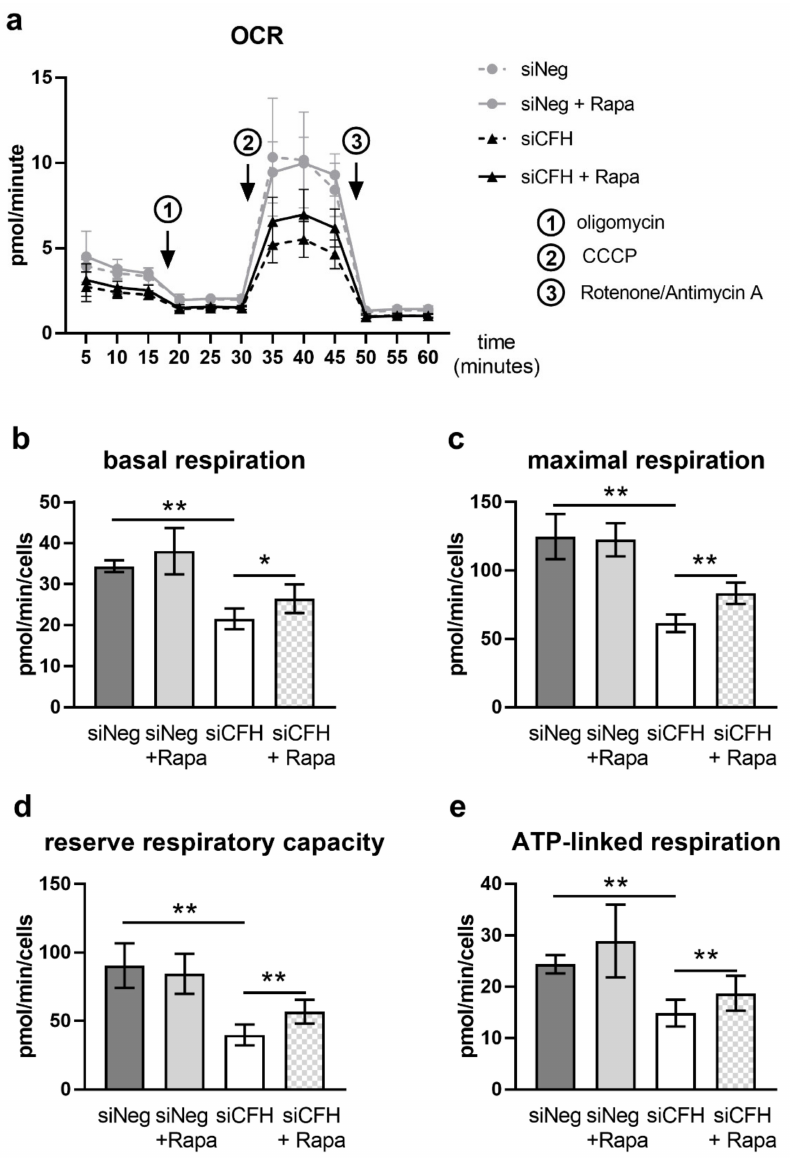
Figure 2. Rapamycin partially rescues FH knockdown-mediated mitochondrial respiration impair- ment in RPE cells. ( a ) hTERT-RPE1 cells were silenced for 24 h with negative control (siNeg) or CFH specific (siCFH) siRNA, seeded on seahorse plates and incubated in SFM containing 200 nM ra- pamycin or DMSO. Curves represent the oxygen consumption rates (OCR) measured after 48 h. SEM shown, n = 4–5. Arrows indicate injection of oligomycin ( 1 ), CCCP ( 2 ), and antimycin and rotenone ( 3 ). ( b – e ) Parameters of mitochondrial respiration were calculated based on the data shown in ( a ). ( b ) Basal respiration, ( c ) maximal respiration, ( d ) reserve respiratory capacity, and ( e ) ATP-linked respiration. Significance was assessed by Student’s t -test; * p < 0.05, ** p <